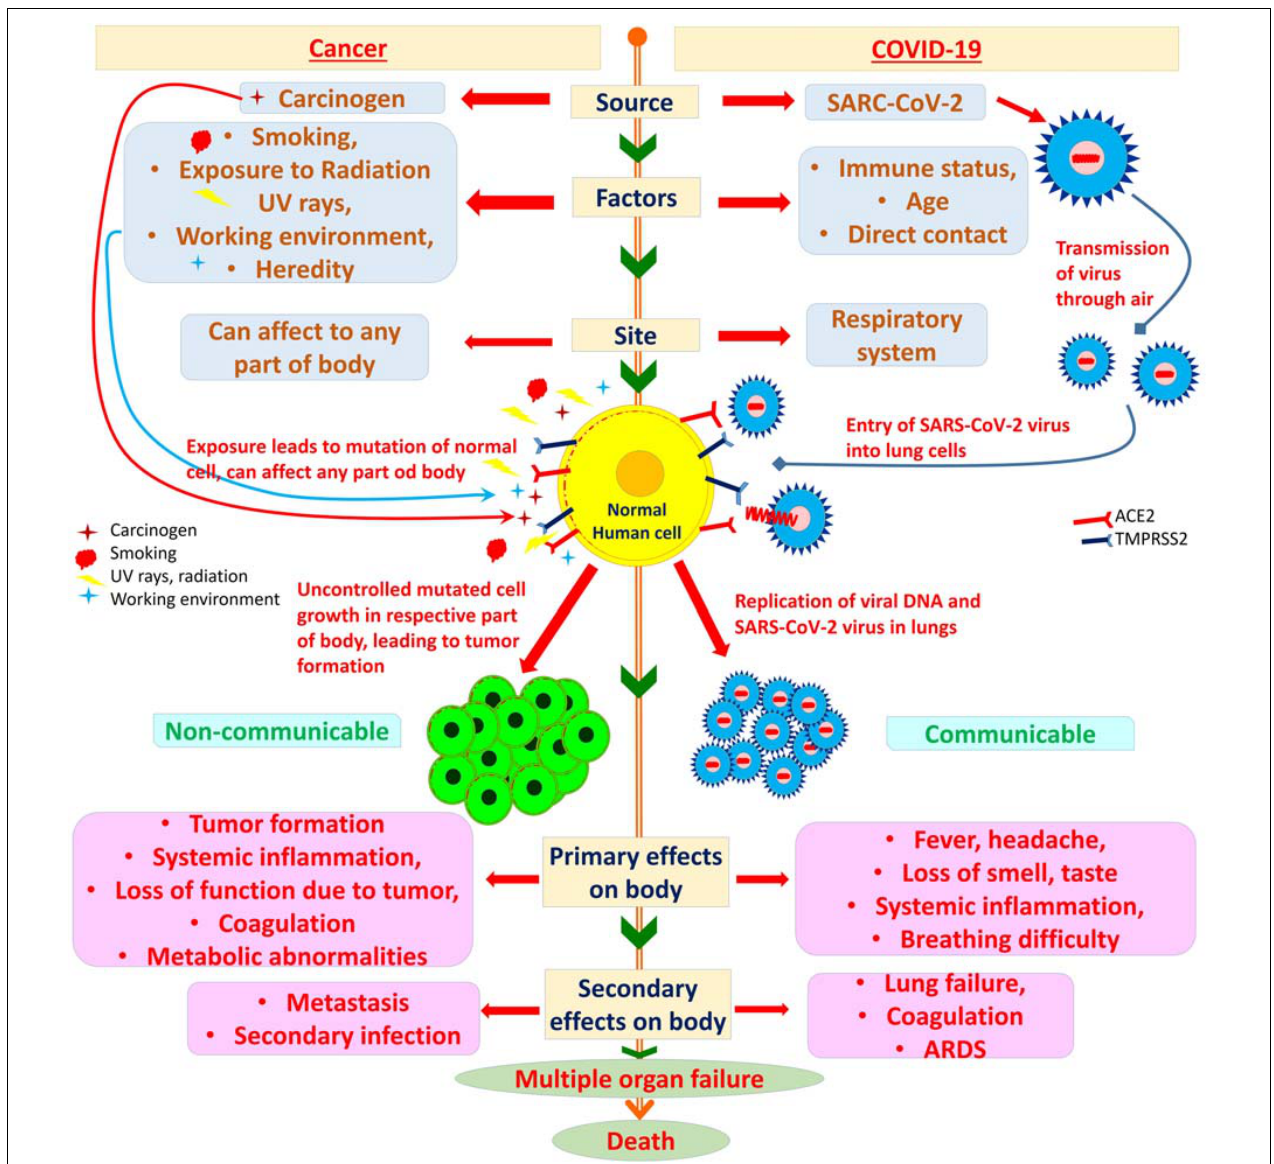
FIGURE 1 | Link between cancer and COVID-19. On the left, cancer progression is illustrated. Cancer is a disease caused by exposure to carcinogens, factors such as smoking, exposure to radiation, UV rays, working environment, and heredity can increase the risk of cancer. Any part of the body can be mutated resulting in cancer. After mutation there is uncontrolled growth of the mutated cells leading to the formation of a tumor, the tumor is non-communicable. Systemic inflammation, loss of function of the respective organ or part of body, coagulation, and metabolic abnormalities are the primary effects of cancer. As cancer progresses to advanced stages, metastasis along with increased susceptibility to secondary infections is observed leading to multiple organ failure and ultimately death. On the right, COVID-19 progression is illustrated. The source of COVID-19, a viral infection, is SARS-CoV-2, risk factors include immune status, age, and direct contact with the virus or infected person. The virus enters through the respiratory system into the human body and gets entry into the lung cells, where the replication of the virus occurs. COVID-19 is highly communicable and leads to fever, headache, loss of smell and taste, along with systemic inflammation and difficulty in breathing. Secondary infection to other organs is observed if the infection is chronic leading to lung failure, coagulation, and acute respiratory distress syndrome. Multiple organ failure leading ultimately to death is observed in